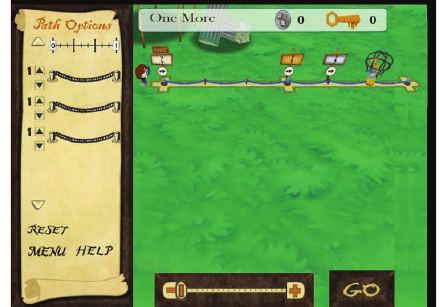
Figure 1: Screenshot of Save